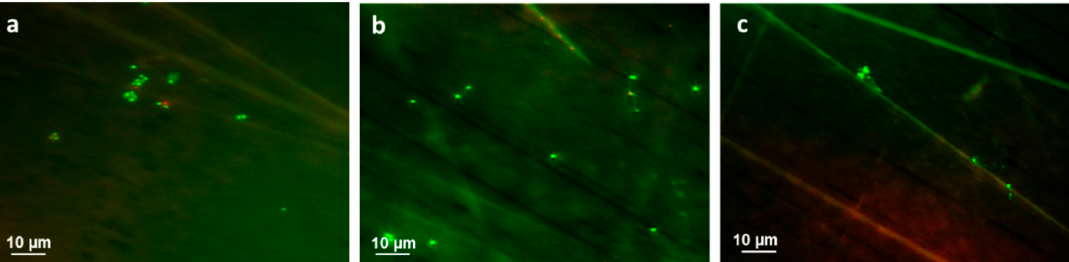
Figure 5. The FTIR spectra comparing pure and modified Nylon 6 samples.